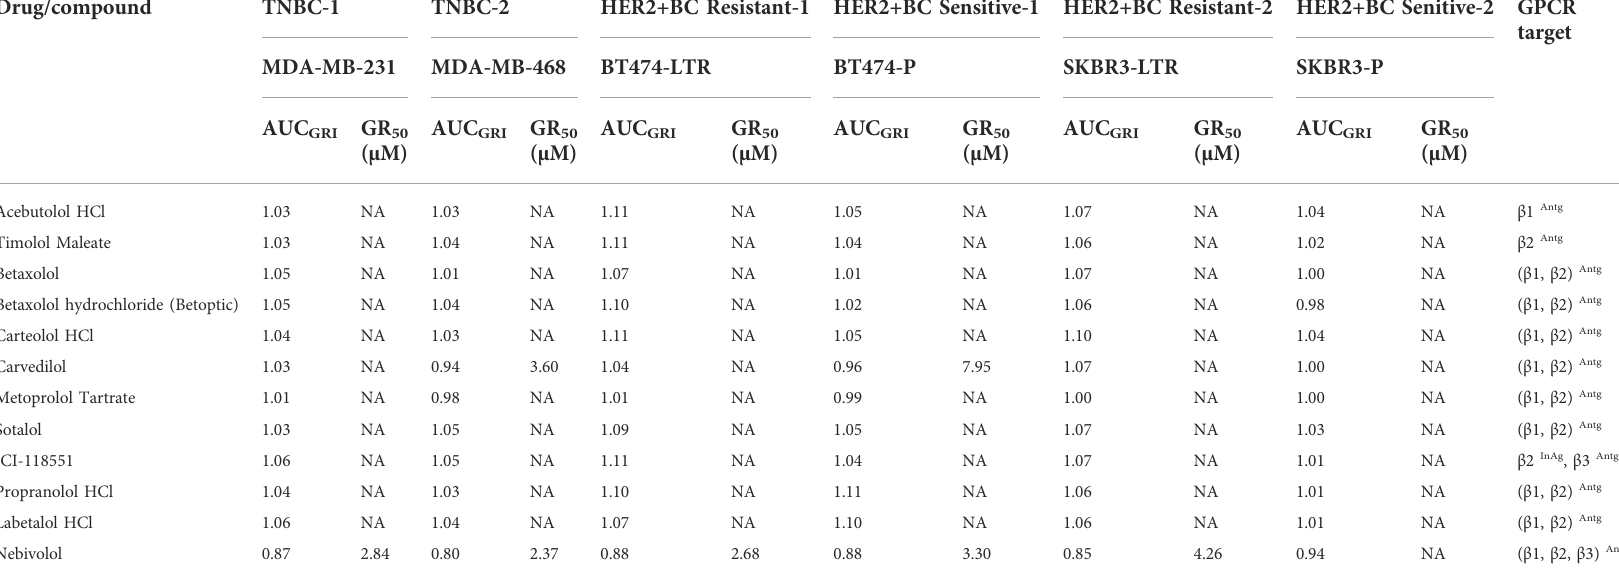
Antg, Antagonist; InAg, Inverse Agonist, NA, not